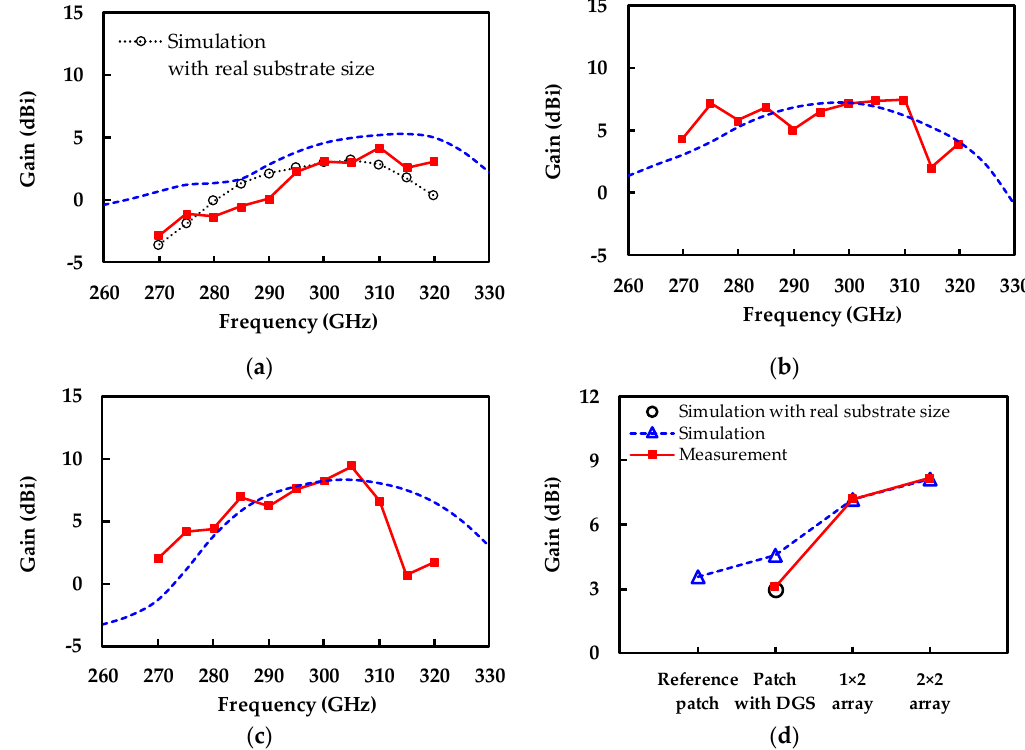
Figure 11. Measured and simulated gain of fabricated on-chip antenna (dashed: simulation, solid with squares: measurement). ( a ) Antenna element. ( b ) The 1 × 2 antenna array. ( c ) The 2 × 2 antenna array. ( d ) Gain comparison.